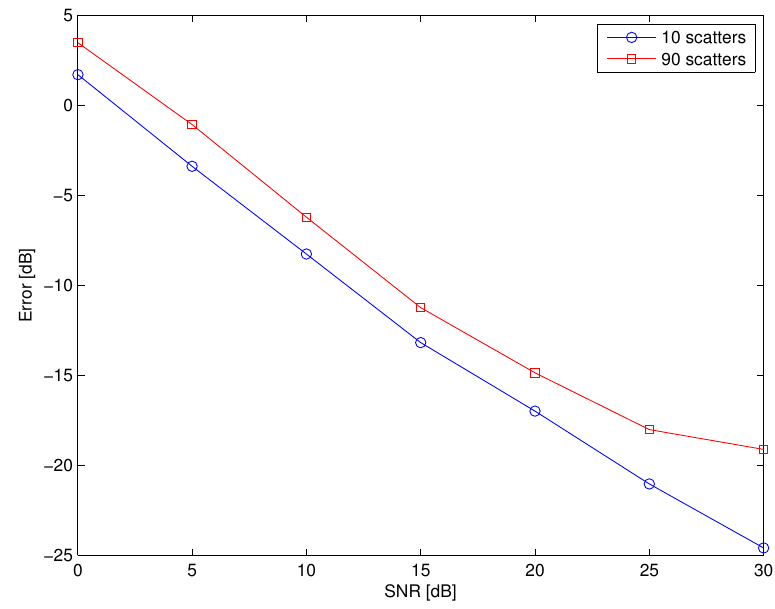
Figure 3. Error (dB) of the singular values estimation versus the signal-to-noise ratio (SNR) in the case of 10 and 90 scatterers (average value on 50 trials); 3 lost elements; measured data affected by the 20-dB noise level.